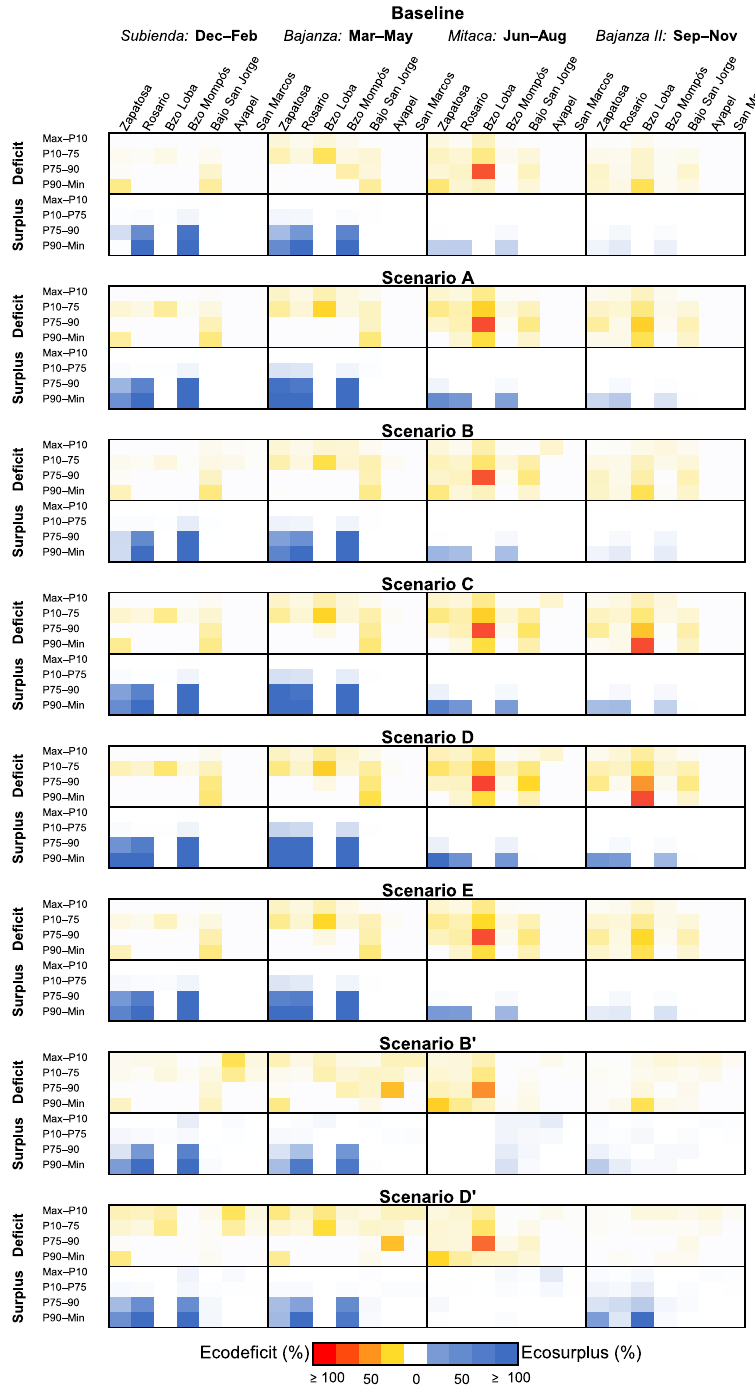
Figure 12. Impacts of upstream regulation scenarios in wetland dynamics for the different floodplain sub-units (see locations in Fig. 5), expressed as ecodeficits or ecosurpluses in the hydroperiod. Seasons correspond to periods of biologic and hydrologic relevance, particularly to fish migration: Subienda (December–February), Bajanza I (March–May), Mitaca (June–August), and Bajanza II (September–November). Ranges of durations representing extreme high (Max– P 10 ), seasonal ( P 10 – P 75 ), low ( P 75 – P 90 ), and extreme low events ( P 90 –Min) are representative of events associated with different ecological or physical processes. Scenarios B’ and D’ consider an alternative operational regime of configurations B and D, to reduce flood peak magnitudes by maintaining low storage in reservoirs to allow regulation of peak